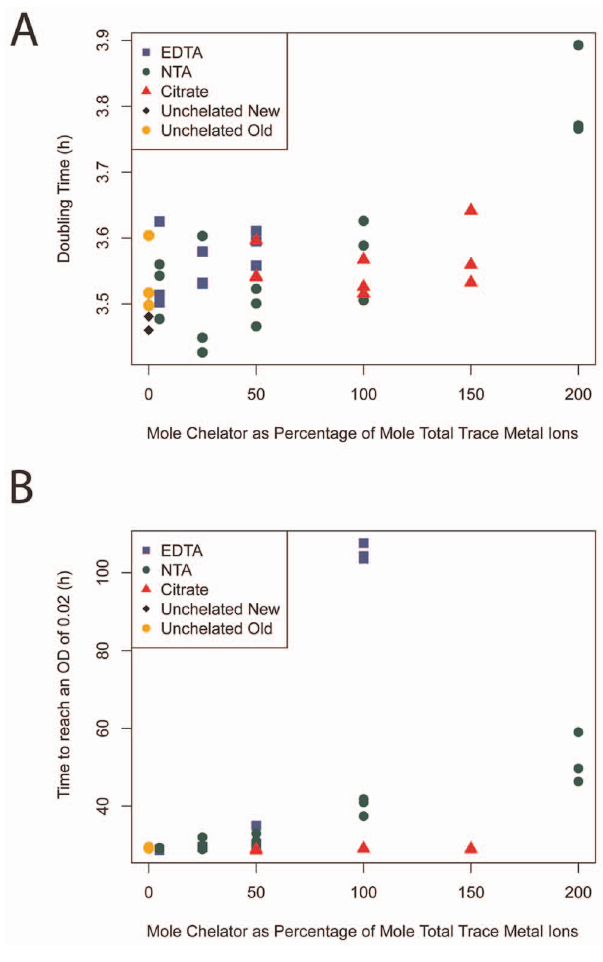
Figure 2. Doubling times of AM1 D cel growing on methylamine using different treatments of chelator and chelator concentra- tion. The concentration of each chelator is shown on the x-axis as a percentage ratio of the moles of the chelator relative to moles of the total trace metal ions (i.e., excluding calcium and magnesium; 100%=25.5 m M). A) The doubling times for the cells under different conditions. Doubling times are not shown for cells growing at 100% or 200% EDTA as these treatments either never increased in OD (the 200% treatment) or did so after a significantly longer time than the other treatments and never achieved a high enough OD to accurately measure a growth rate (the 100% treatment). B) Time taken for cultures to reach an OD of 0.02 in hours (calculated by interpolation of the growth curve).